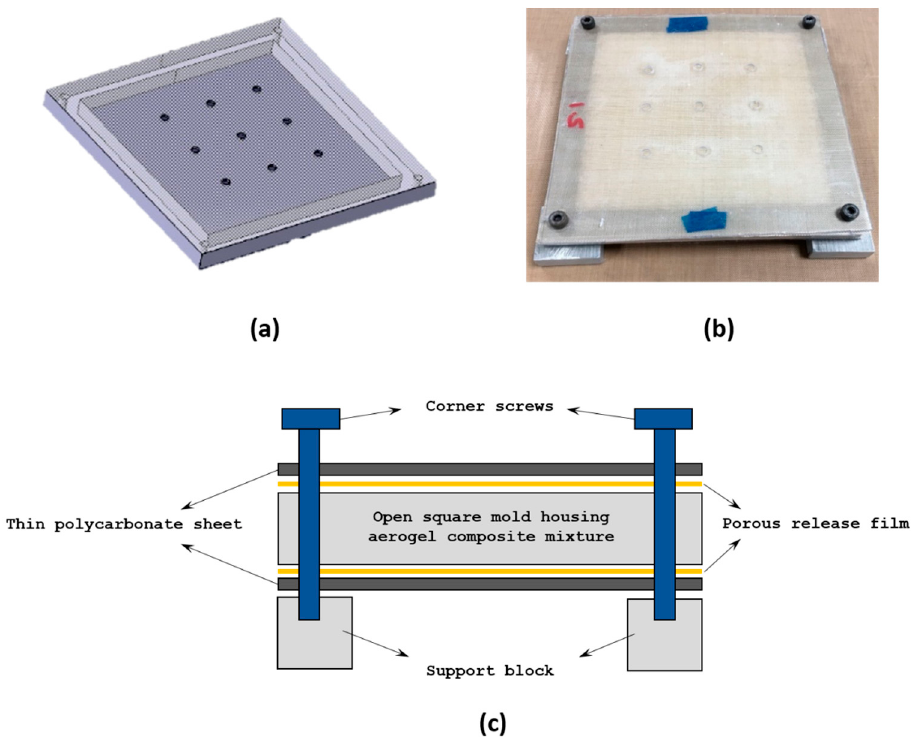
Figure 2. Proposed compact mold design MDP02 ( a ) Thin polycarbonate sheet having uniform holes over the surface ( b ) Assembled mold ( c ) Pictorial representation of assembled mold design.